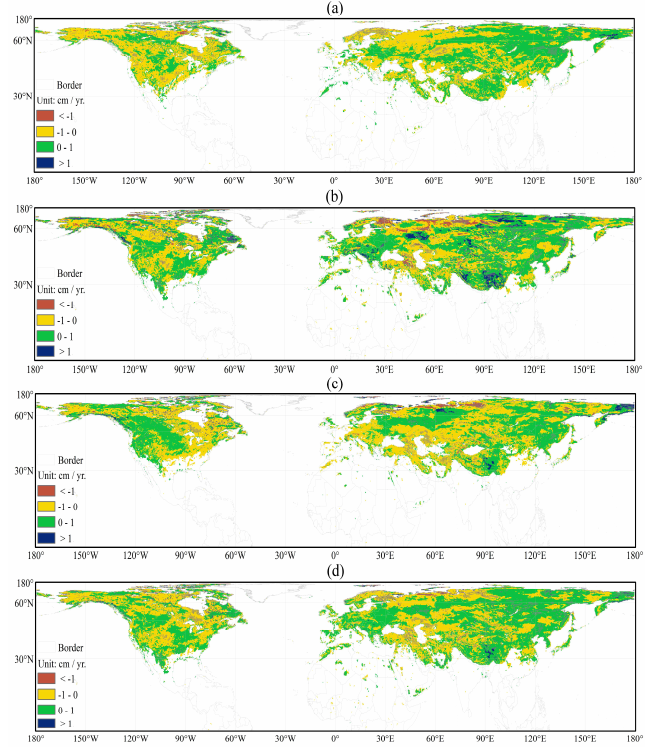
Figure A1. The variation rate pattern of annual average SD ( d ) and seasonal average SD ( a – c ) over the Northern Hemisphere for three snow cover seasons, namely, autumn ( a ; September to November), winter ( b ; December to February), and spring ( c ; March to June) from 1992–2001. The black dots in ( a – d ) indicate that the changes are significant at a 95% confidence level (CL).